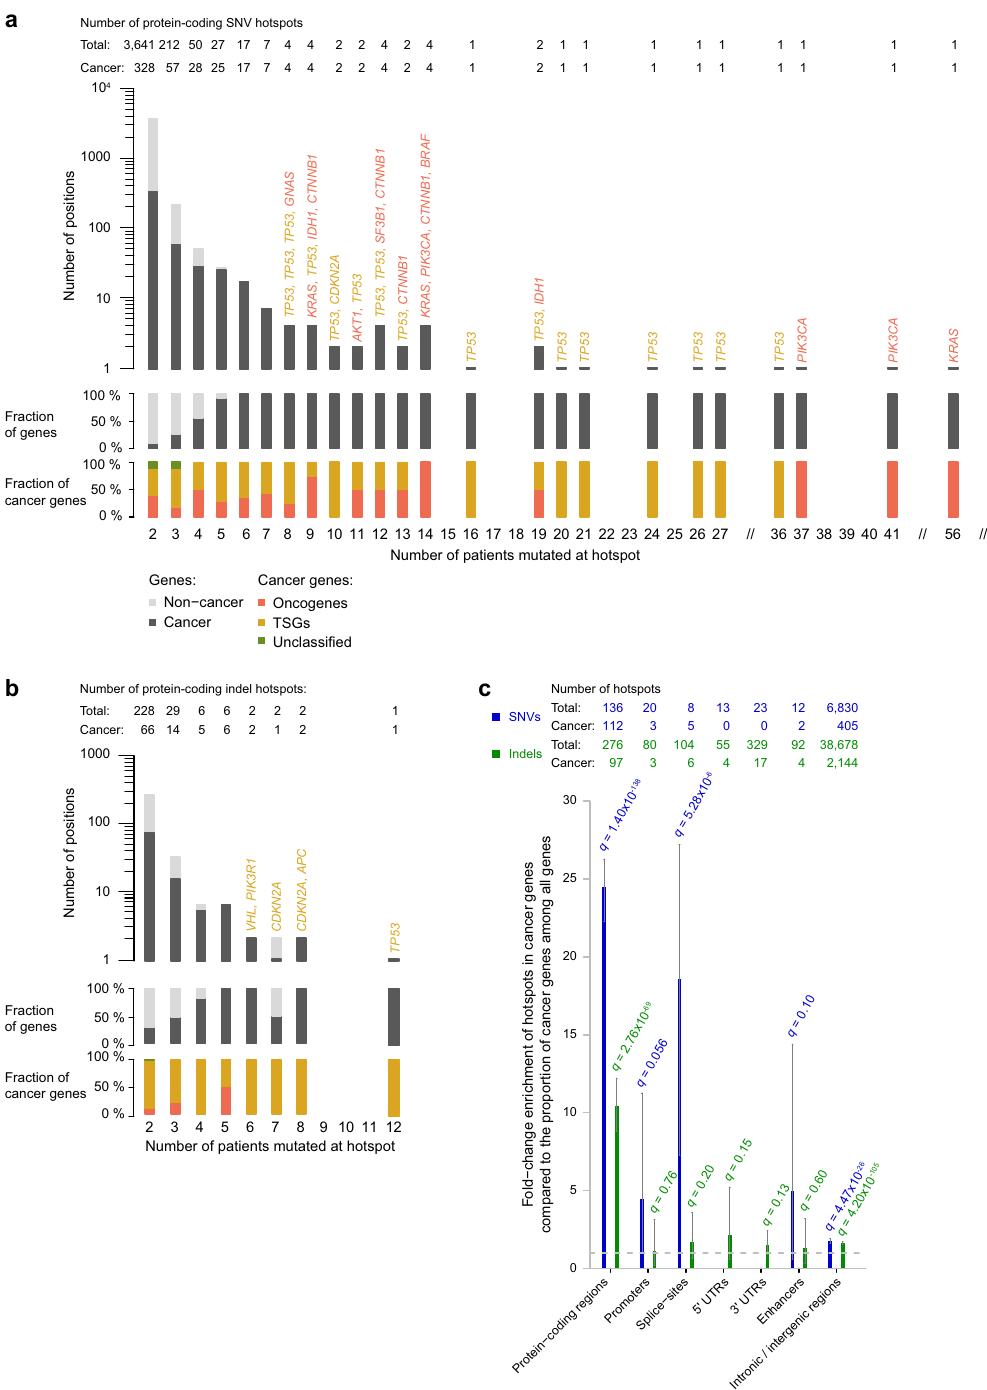
Fig. 2 Cancer gene enrichments. a – b Bar-charts of protein-coding SNV (a) and indel (b) hotspots; numbers above bars indicate the total number of hotspots and hotspots in cancer genes; gene names are shown for hotspots in oncogenes and tumor suppressors with more than seven (SNVs)/ fi ve (indels) mutations; the middle bar-plot show the fractions of cancer genes among the hotspots; the lower bar-plot show the fraction of oncogenes, tumor suppressors, and unclassi fi ed cancer genes in the total amount of cancer genes. The remaining regions are included as Supplementary Fig. 2 for SNVs and Supplementary Fig. 3 for indels. c Fold-change enrichment of hotspots in known cancer genes relative to the overall proportion of cancer genes among all genes (699/20,805); numbers above bars are the total number and number of cancer hotspots in each region; error bars are Clopper-Pearson 95% con fi dence interval approximations. TSGs: Tumor suppressor gene regulatory hotspots where we know that binding is possible For SNVs, 36 of the 212 highly mutated hotspots overlapped by selecting the hotspots that overlap ENCODE transcription factor TFPs. Of these, seven overlapped individual transcription factor binding peaks (TFP; see “ Methods ” section). This includes 212 SNV motifs and fi ve of these were found to potentially cause gain or hotspots and 936 indel hotspots. loss (see “ Methods ” section). Only one of these is previously